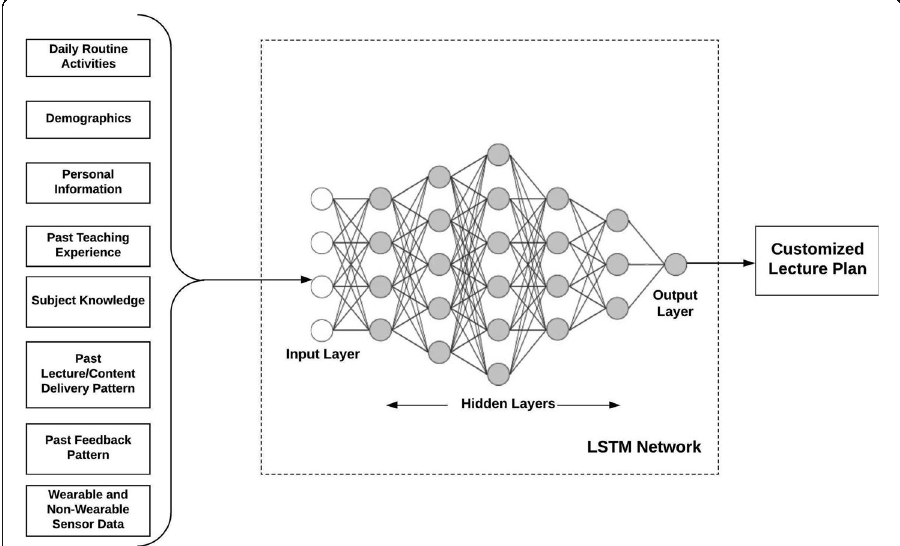
Fig. 8 System for Customized Lecture Plan. The multiple inputs from the teachers are passed to the